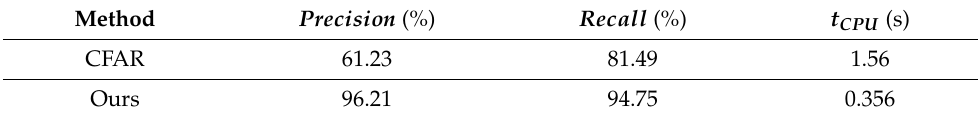
Table 11. Quantitative comparison with CFAR on